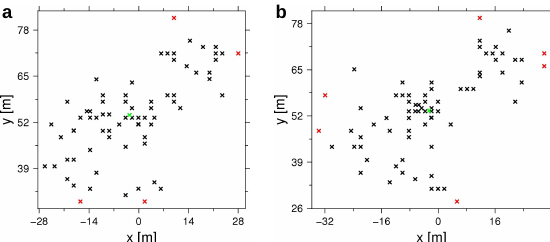
Figure 4. The residual shifts in local stereographic map coordinates x , y of the 74 LOLA tracks to the TC1 DTM from Fig. 3a. Considered residuals are shown as black crosses, outliers are shown as red crosses and the common offset between the DTM and all tracks is shown as a green cross. (a) Original LOLA frame. (b) New LOLA frame. tracks are expected to be less precise. From the available 278 tracks 79 orbits are also part of the new LOLA frame. We co- registered these orbits from each of the two LOLA frames to the TC2 DTM, filtered outliers and determined the residuals for each data set (Fig. 5). In total 75 tracks were considered regarding the original LOLA frame and 73 tracks regarding the new LOLA frame.